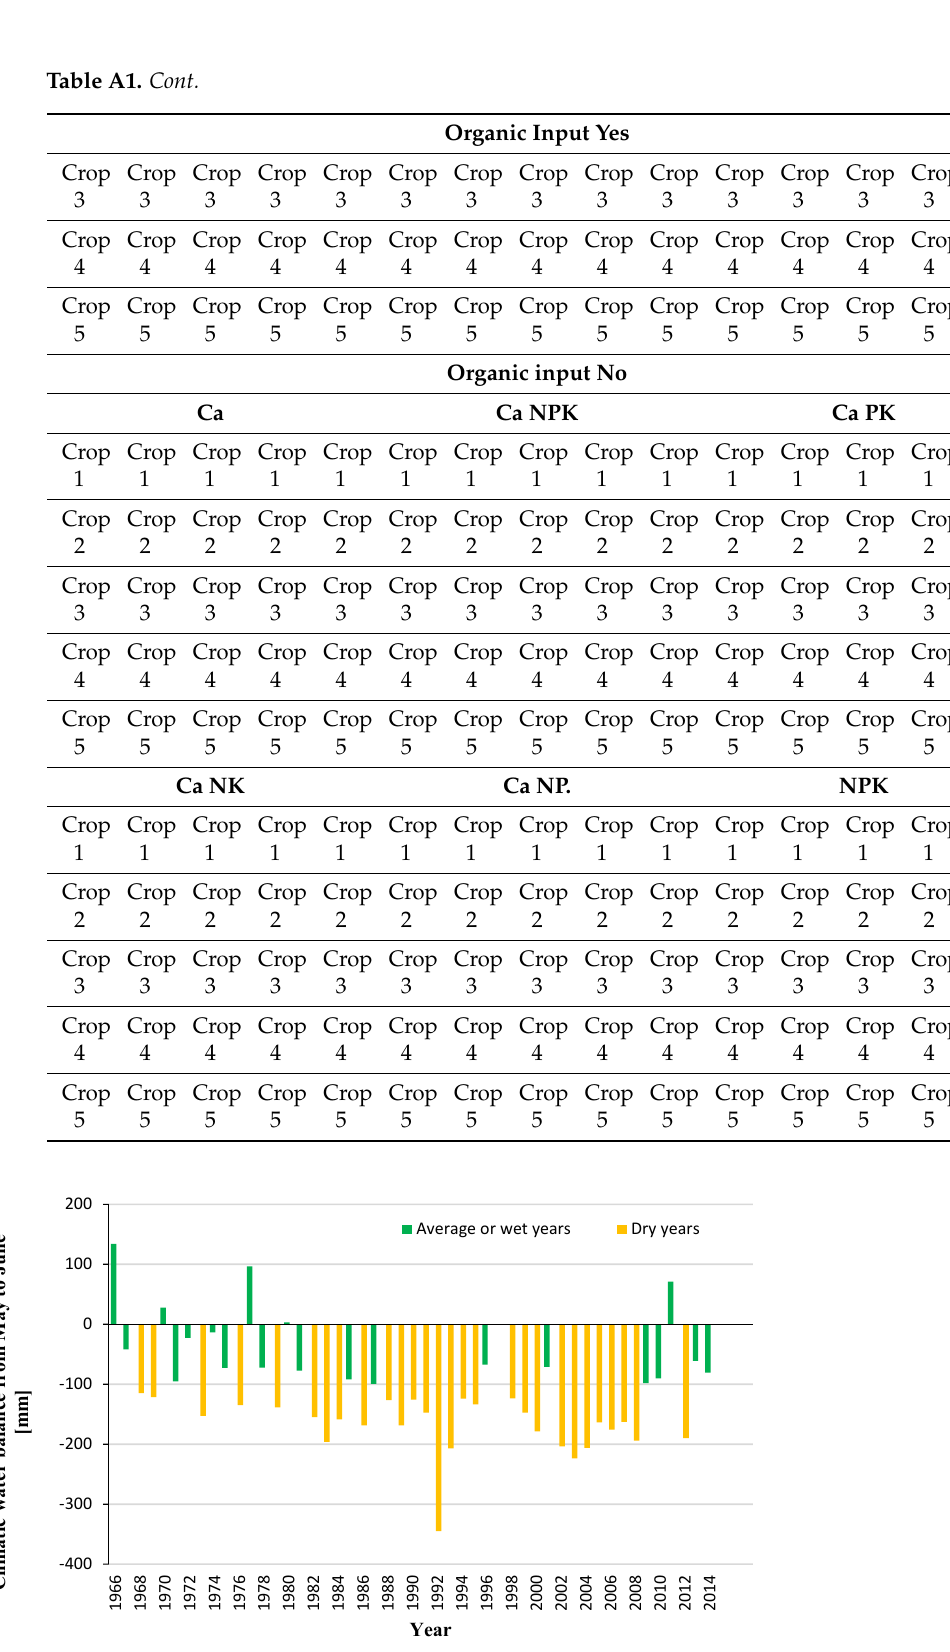
Figure A1. Climatic water balance (CWB) from May to July [mm] in 1966–2015 period in Warsaw University of Life Science Experimental Station in Skierniewice, Poland. Dry years: CWB from May to June ≤− 100 mm (n = 27); Average or wet years: CWB from May to June >−100 mm (n = 22).